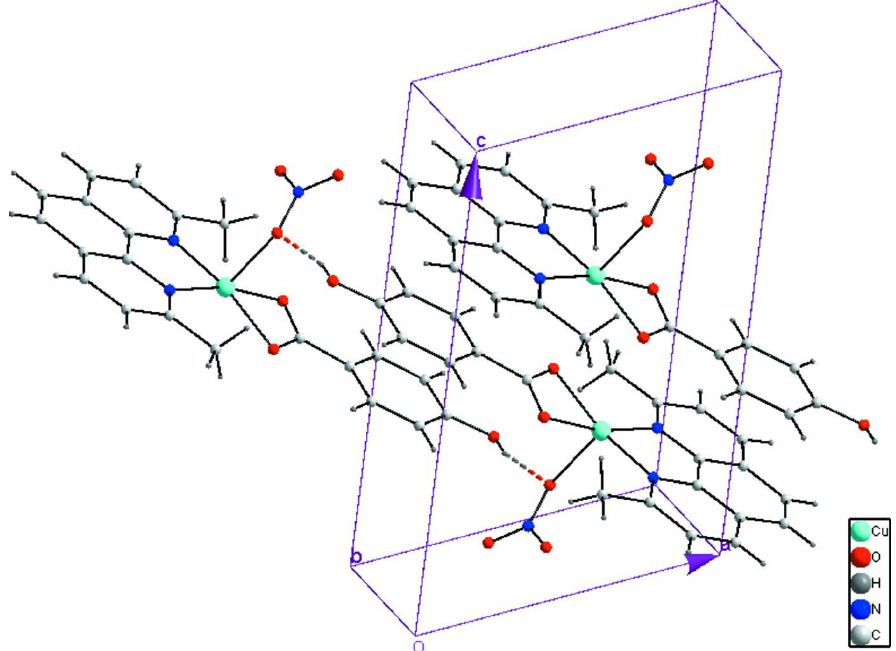
Figure 2 The hydrogen-bonding motifs, and π - π interactions between the aromatic rings of neighboring molecules in the crystal structure of the title compound. Dashed lines indicate the hydrogen